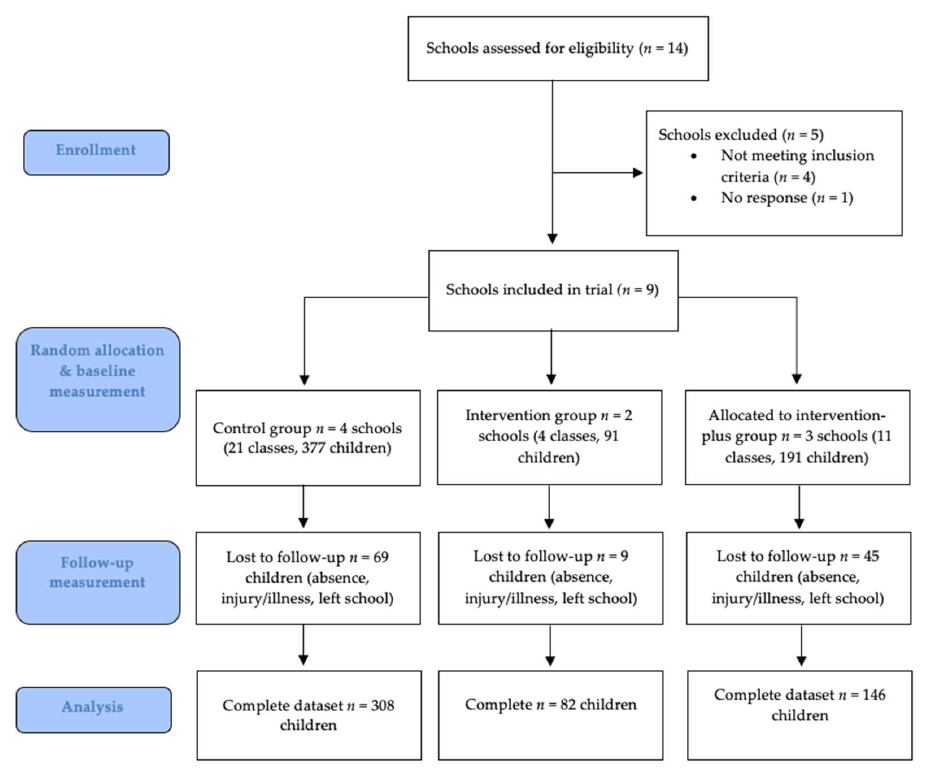
Figure 1. Flow diagram of participants and study design (CONSORT 2010 Flow Diagram).